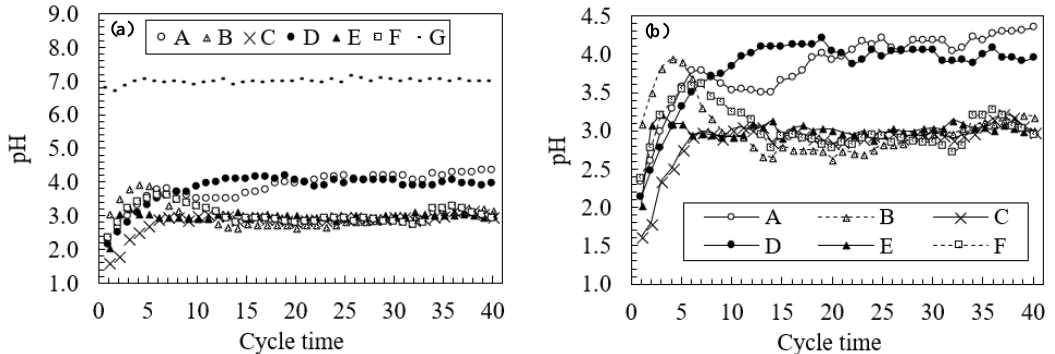
Figure 3. ( a ) Changes in pH over the 40 leaching cycles during the leaching test; ( b ) changes in pH without sample G.